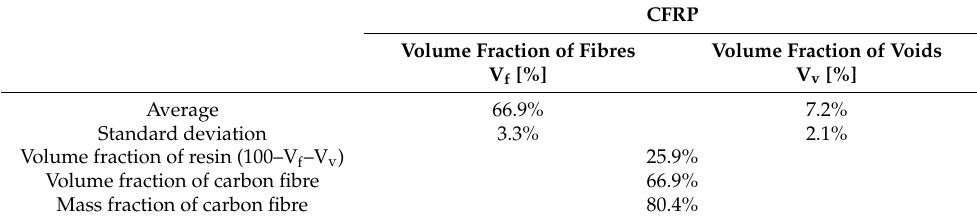
Table 2. Summary of microstructure surface measurements of CFRP.